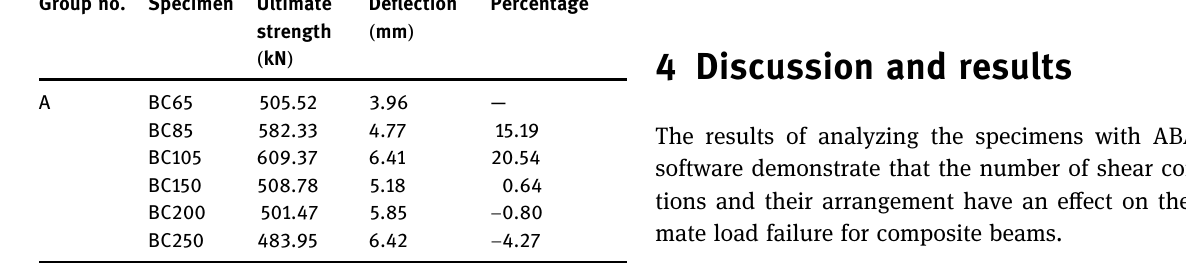
Table 2: Ultimate strength and de fl ection of midspan of group A Group no. Specimen Ultimate